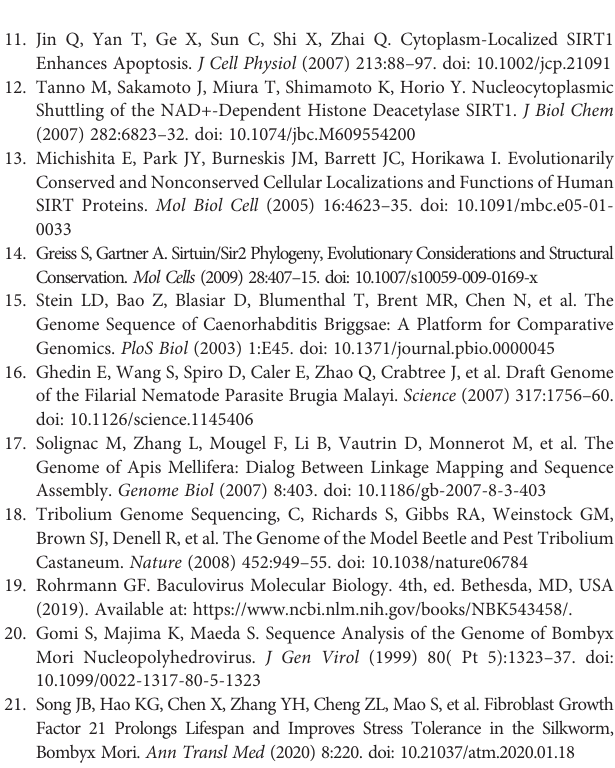
Supplementary Figure 1 | Quanti fi cation of BmSirt7 expression by RT-PCR in the hemocytes, fat body and midgut. (A) Expression of BmSirt7 in the uninfected silkworm. M: molecular weight marker (DL5000). (B) Expression of BmSirt7 in the BmNPV-infected silkworm. M: molecular weight marker (DL2000). The Rp49 gene was used as reference gene. Supplementary Figure 2 | Sirtuin expression after speci fi c knockdown in BmN cells at 24 h, 48 h, 72 h and 96 h. (A) BmSirt2 , (B) BmSirt4 , (C) BmSirt5 and (D) BmSirt6 . Each bar represents the mean ± SD. **p < 0.01, ***p < 0.001, ****p <